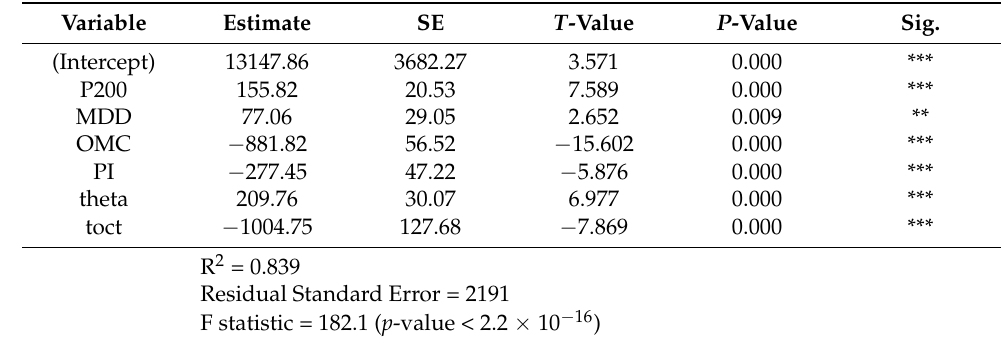
Table 4. Model Estimation Results (MLR Model).